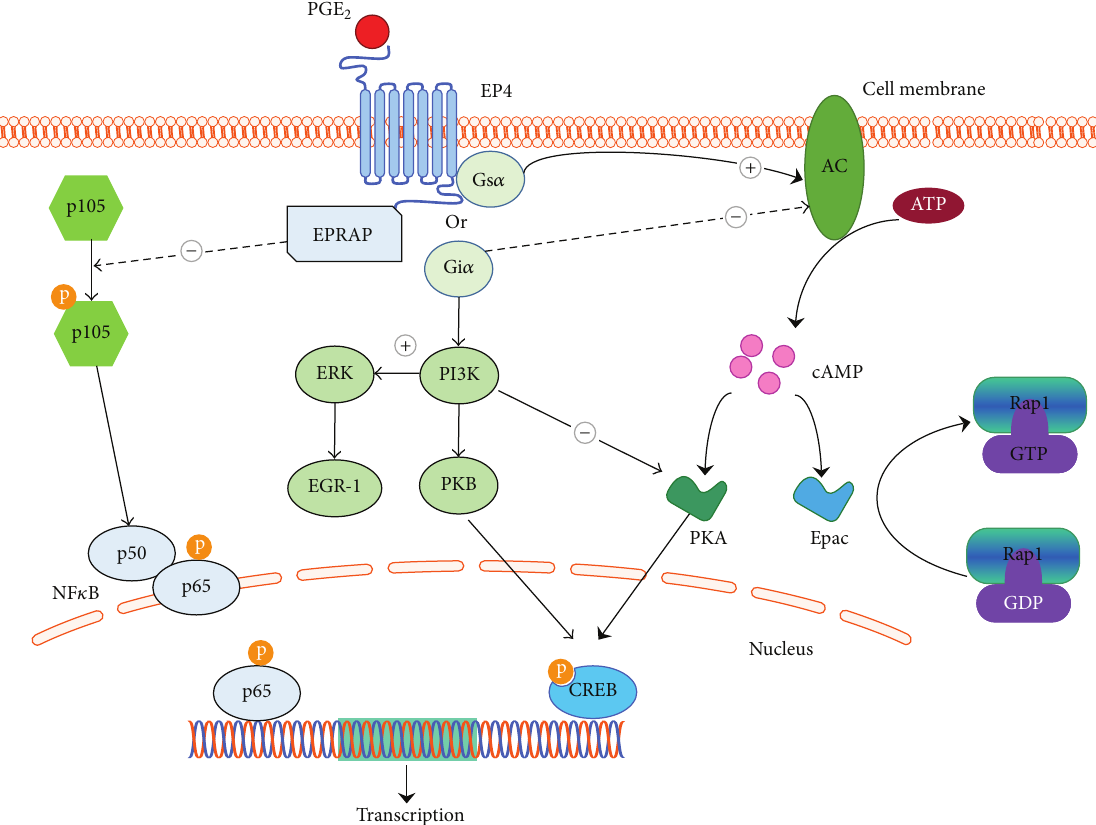
Figure 1: Differential signaling pathway of EP4. In response to PGE 2 , activation of EP4 stimulates stimulatory G 𝛼 protein (Gs 𝛼 )/cyclic adeno- sine monophosphate (cAMP)/protein kinase A (PKA)/cAMP response element binding protein (CREB) pathway or Gs 𝛼 /cAMP/exchange protein directly activated by cAMP (Epac) pathway. EP4 is also coupled to inhibitory G 𝛼 protein (Gi 𝛼 ), which inhibits the cAMP/PKA/CREB pathway. Furthermore, EP4 activates phosphatidylinositol 3-kinase (PI3K) through activation of Gi 𝛼 . Activation of PI3K not only stimulates the protein kinase B (PKB)/CREB pathway but also induces the expression of early growth response factor 1 (EGR-1) through extracellular signal-regulated kinase signaling. Prostaglandin E receptor 4-associated protein (EPRAP) can inhibit phosphorylation of p105 and further suppress the activation of nuclear factor kappa B (NF 𝜅 B). AC = adenylyl cyclase; ATP = adenosine triphosphate; GDP = guanosine diphosphate; GTP = guanosine